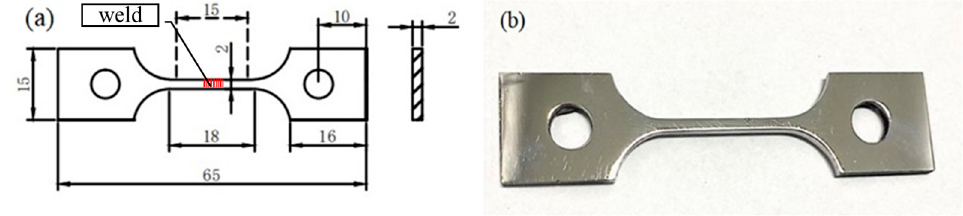
Figure 1. Illustration of macroscopic tensile test specimen: ( a ) Dimensions of tensile specimen (in mm); ( b ) View of test specimen.